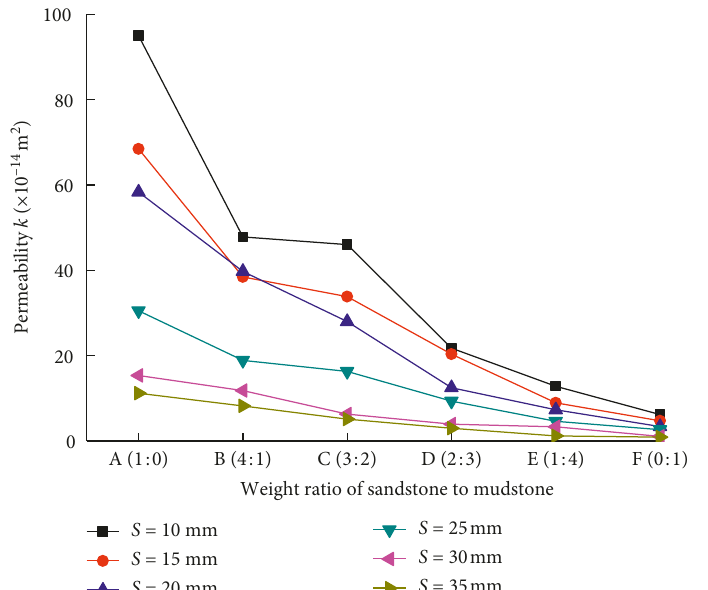
Figure 9: Permeability as a function of increasing mudstone content in samples subjected to different axial displacements ( S